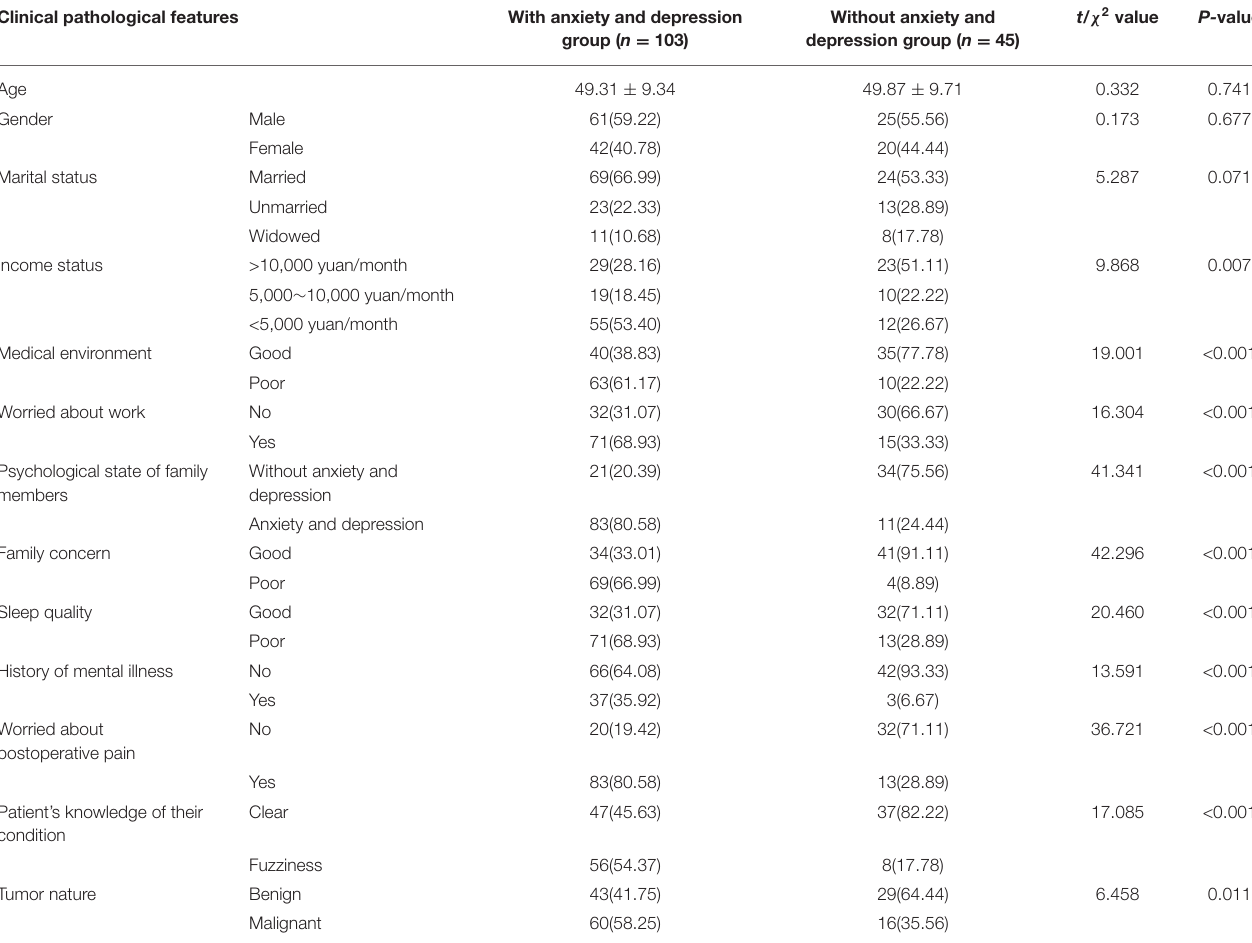
TABLE 1 | Univariate analysis of psychological status of patients with pulmonary tumor during perioperative period. Clinical pathological